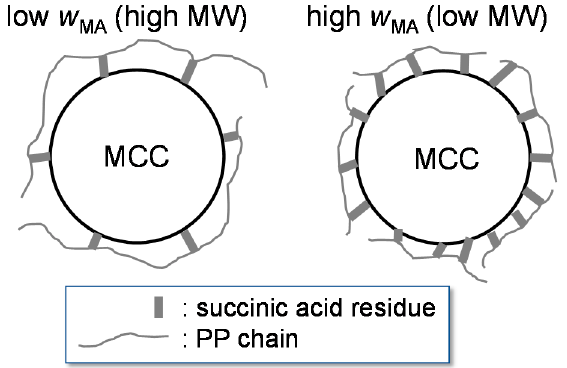
Figure 10. Schematic of MCC coated by MAPP with various w MA values. Reprinted from Ref. [33]. Copyright Elsevier Ltd. (2019).